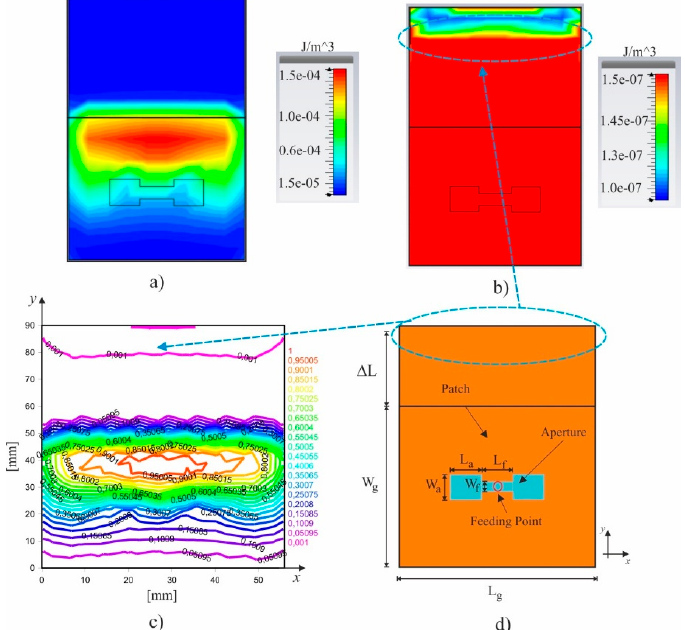
Figure 3. ( a ) Electric energy density on the ground plane for the antenna with ∆ L = 40 mm. ( b ) Electric energy density on the ground plane for the antenna with ∆ L = 40 mm with the maximum peak set to a value 10 3 times lower than the one shown in ( a ). ( c ) Normalized Electric energy density on the ground plane for the antenna with ∆ L = 40 mm represented with contour lines. ( d ) Profile of the extended ground plane following the electric energy density shown in ( b ), with Δ L = 30 mm.